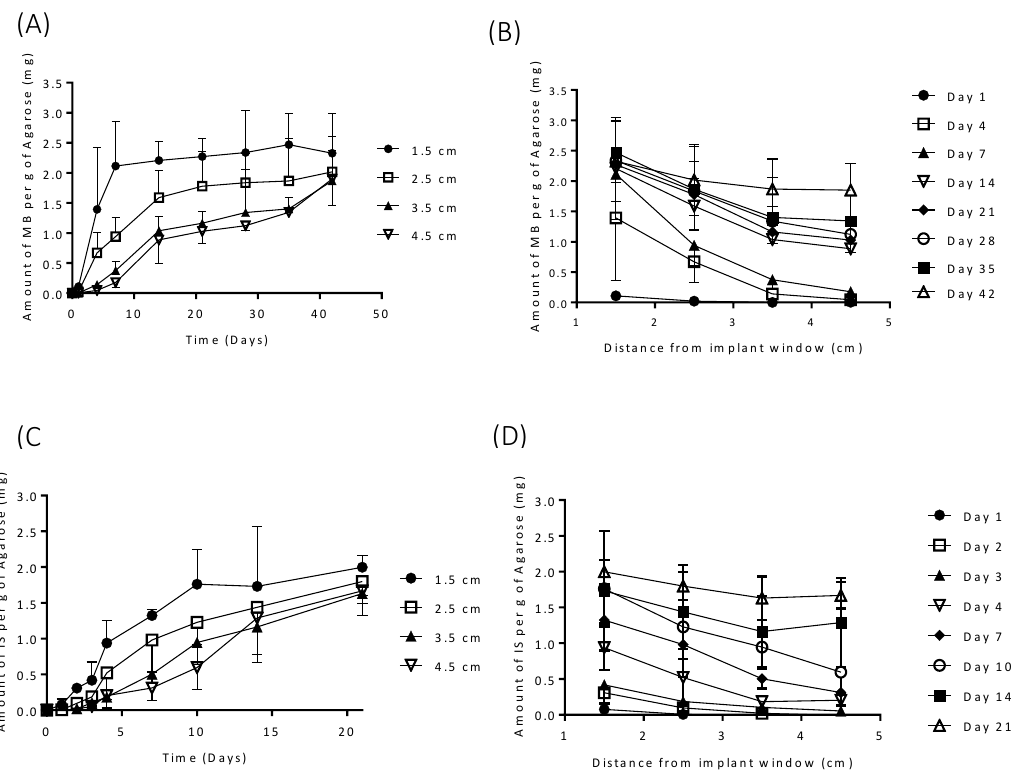
Figure 8. ( A and B ) MB and ( C and D ) IS releases from ( A ) Implant E into agarose gel ( n = 3, means ± SD).